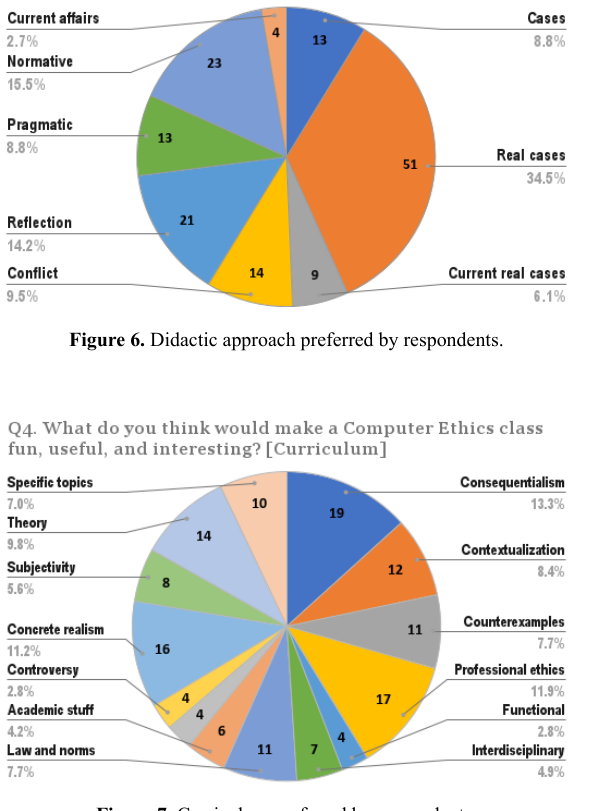
Figure 7. Curriculum preferred by